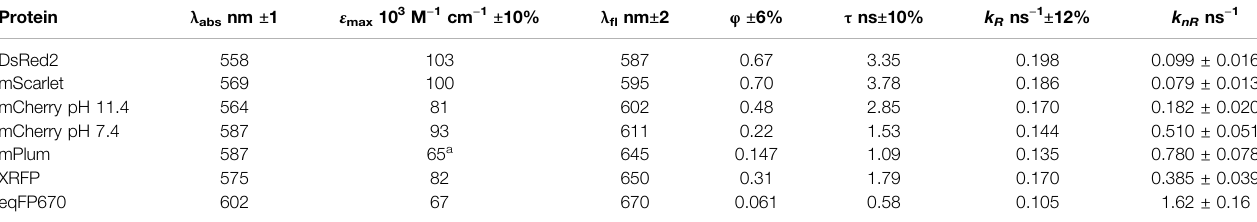
TABLE 1 | Absorption and fl uorescence properties of RFPs. Protein